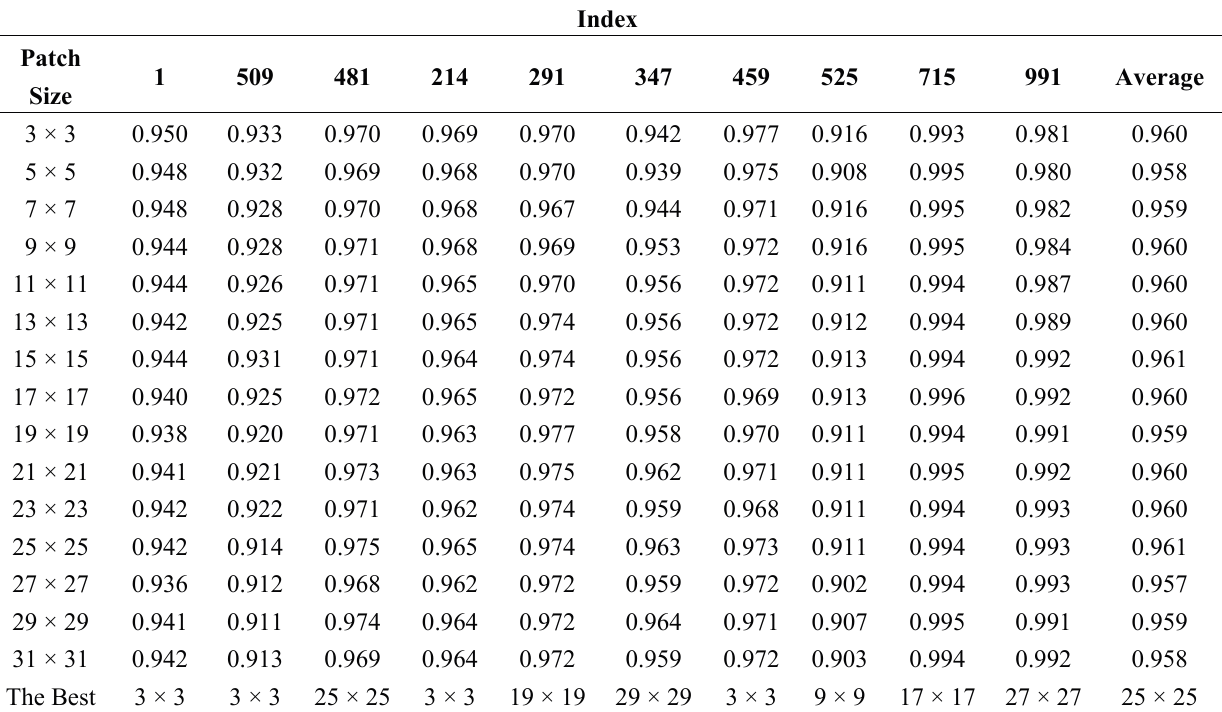
Table 2. Mean SSIM after denoising vs. patch